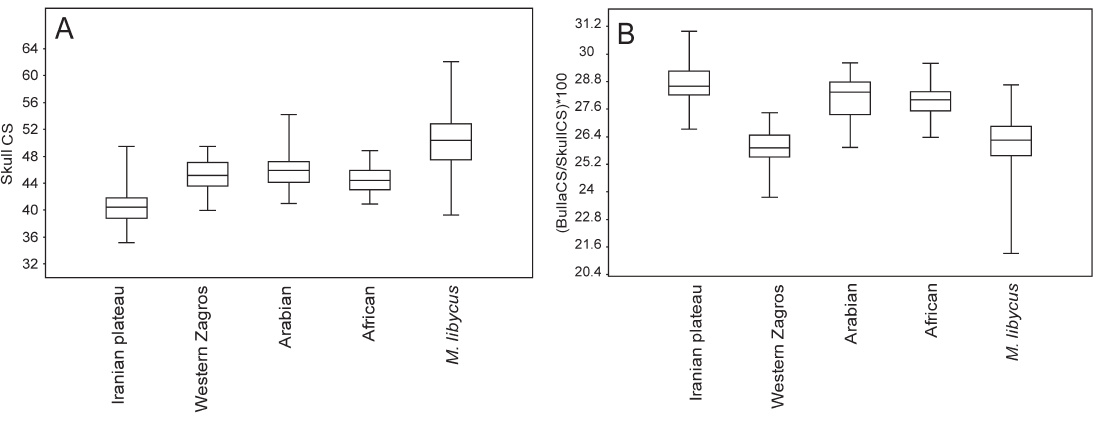
Fig. 5. Box-and-whisker plots of (A) skull size and (B) relative bulla size of the ventral cranium. The boxes indicate the 25–75 % quartiles; the whiskers represent the minimal and maximal